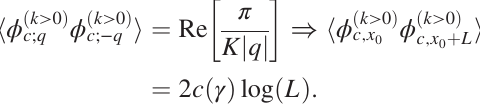
FIG. 5. Prefactor of the logarithmic scaling function (effective central charge) c ð γ Þ obtained from integrating the RG equa- tion (53) for the parameter K . For λ ¼ 0 , we observe the scaling c ð γ Þ ∼ γ − 0 . 5 (red line and inset). For λ ≠ 0 , a transition into the area law phase happens at a critical measurement strength γ where c ð γ Þ drops to zero. In the weak measurement regime, c ð γ Þ increases with λ . The lines correspond to λ ¼ 0 . 2 γ (light gray, solid), λ ¼ 0 . 25 γ (dark gray, dashed), and λ ¼ 0 . 3 γ (black,